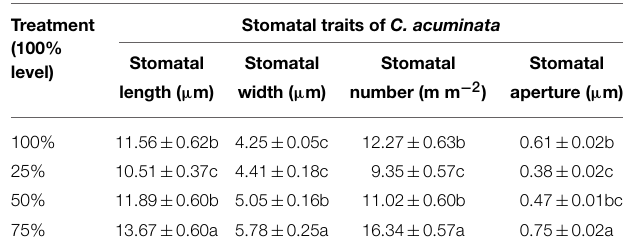
TABLE 4 | Light intensity and stomatal traits in C. acuminata